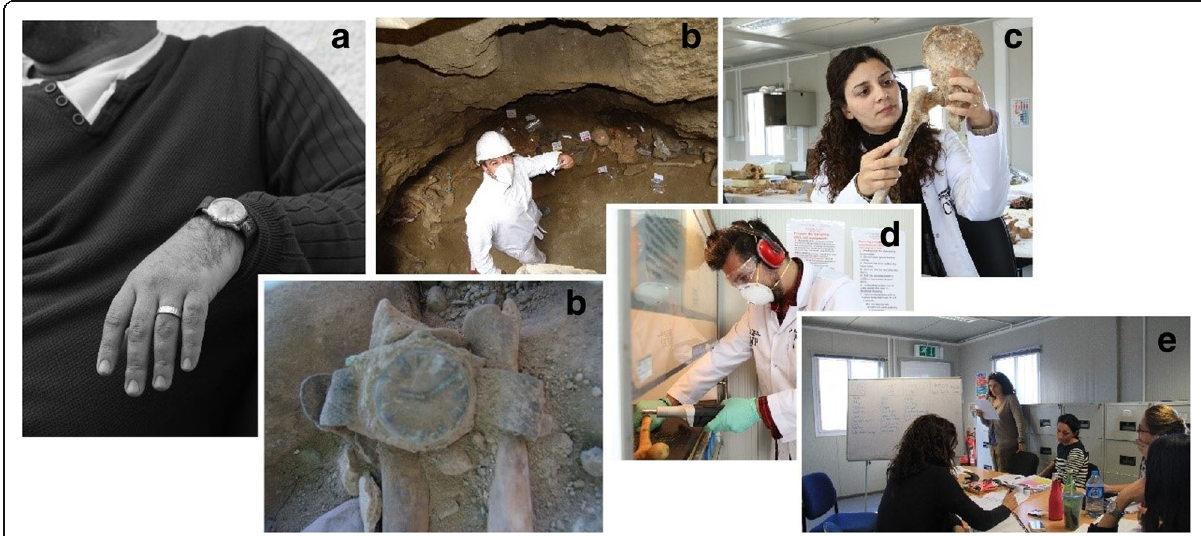
Fig. 5 The stages of the CMP forensic identification analyses: ( a ) the antemortem information on a missing person, ( b ) the exhumation of remains and encountering an artefact on the individual, ( c ) anthropological analysis, ( d ) preparation of skeletal sample for DNA testing, ( e ) the reconciliation